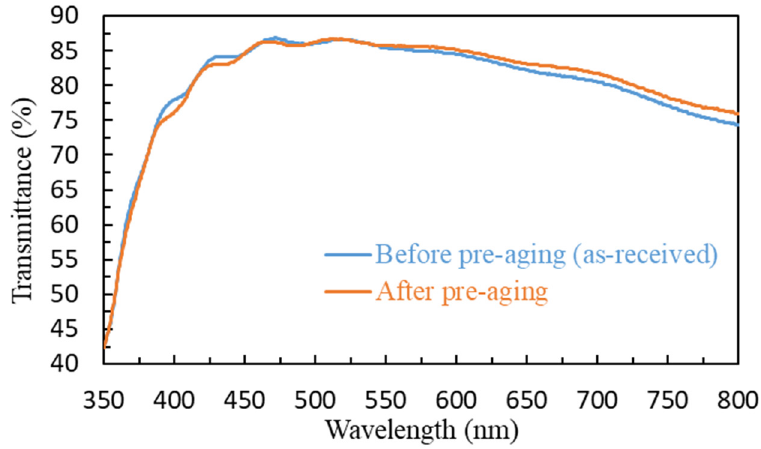
Figure 2. UV–Vis spectra of the OMO sample as received and after pre-aging.